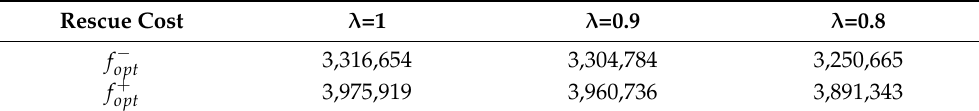
Table 9. The upper and lower bounds of the total cost under different confidence levels